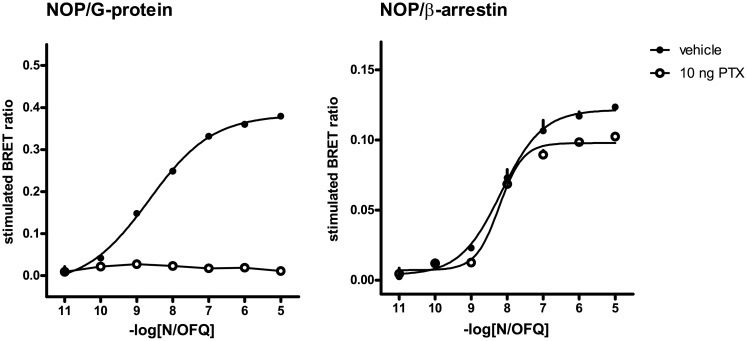
Concentration-response curves to N/OFQ—experiments performed in absence and in presence of PTX 10 ng 20 h treatment.NOP/G-protein (left panel) and NOP/β-arrestin 2 interaction experiments (right panel). Data are mean ± sem of 3 separate experiments performed in duplicate.